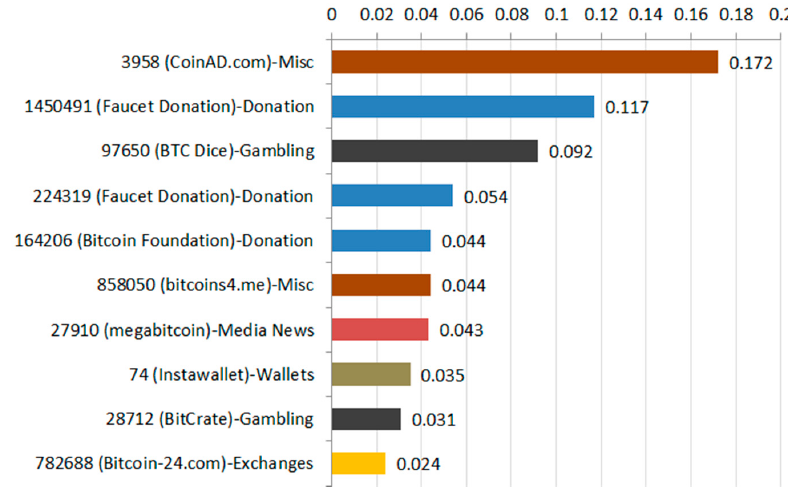
Figure 30. Degree Centrality for Business (Excluding the Top 3).